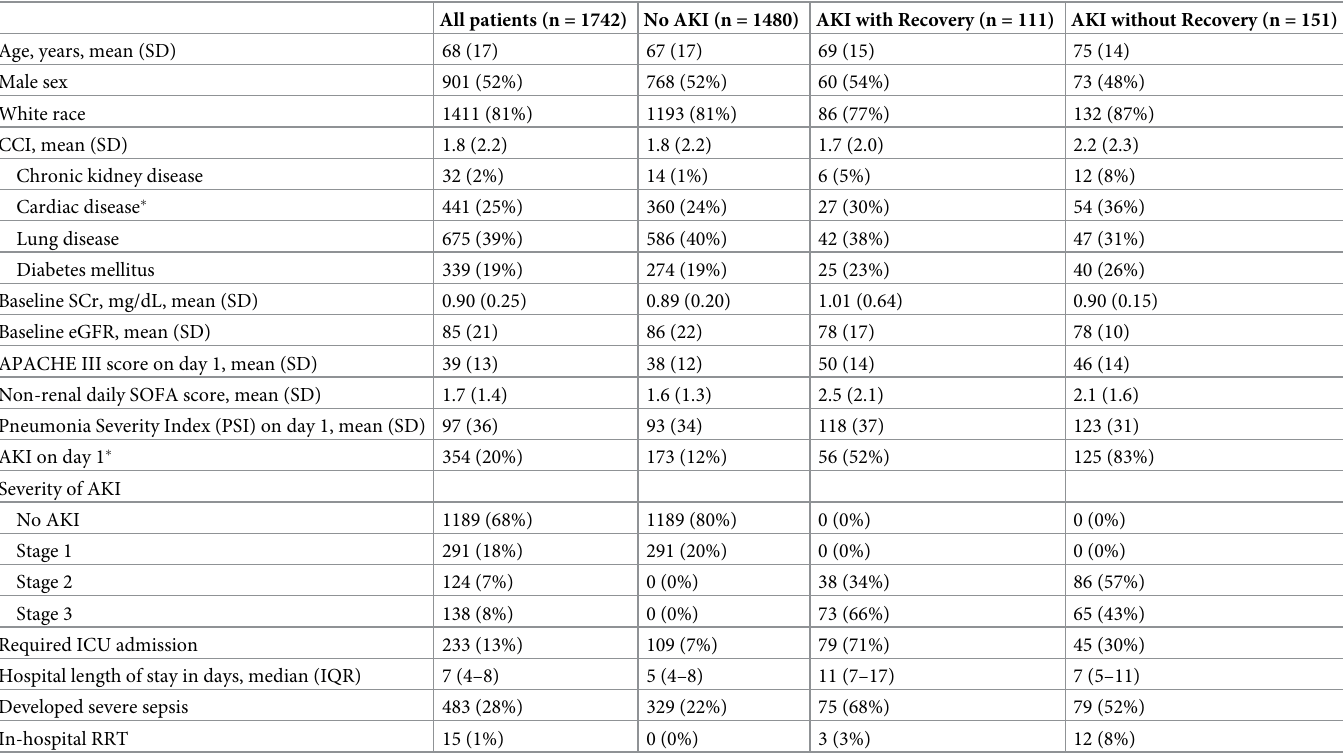
Table 1. Baseline characteristics and hospital outcomes of the study population.